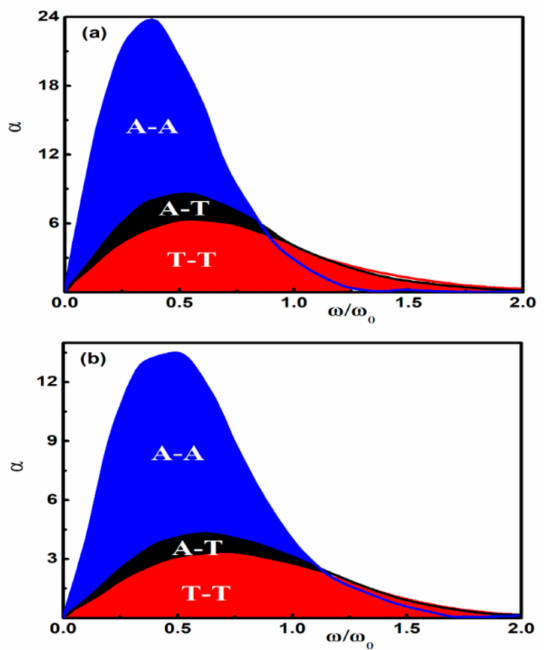
Figure 5. Threshold curve α (= γω 0 d/F 0 ) vs. driving frequency ω / ω o (with ω o the natural frequency of the system). The area below the curve defines the condition that can possibly lead to chaotic motion. The values of δ Cas and the initial distances d considered here were ( a ) δ Cas = 0.065 and d = 250 nm and ( b ) δ Cas = 0.031 and d = 1 µ